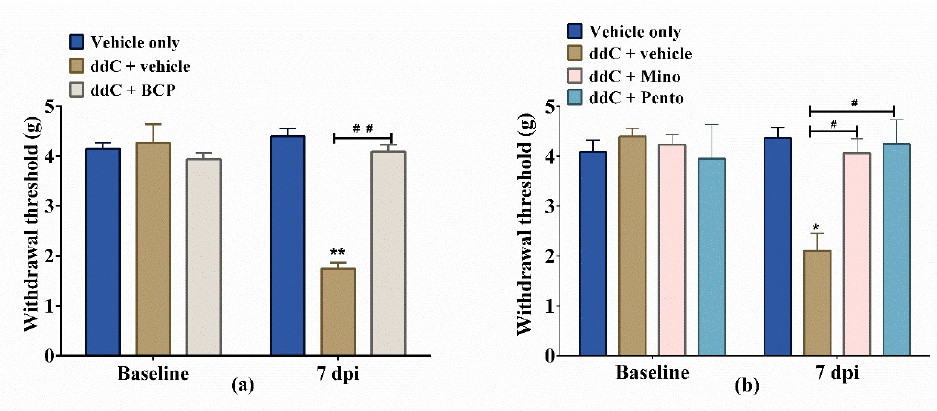
Figure 2. β-Caryophyllene (BCP), minocycline (Mino) and pentoxifylline (Pento) prevent the development of 2′-3′-dideoxycytidine (ddC)-induced mechanical allodynia in female BALB/c mice. The effect of treatment with ( a ) BCP, ( b ) minocycline and pentoxifylline on the development of ddC- induced mechanical allodynia at day 7 post-first-injection (dpi) of ddC. Each bar represents the mean ± SEM of values obtained from seven to eight animals. * p < 0.05, ** p < 0.01 compared to vehicle-only- treated control mice at day 7, and # p < 0.05, ## p < 0.01 compared to mice treated with ddC + vehicle (two-way repeated measures ANOVA followed by Sidak’s multiple comparisons test).